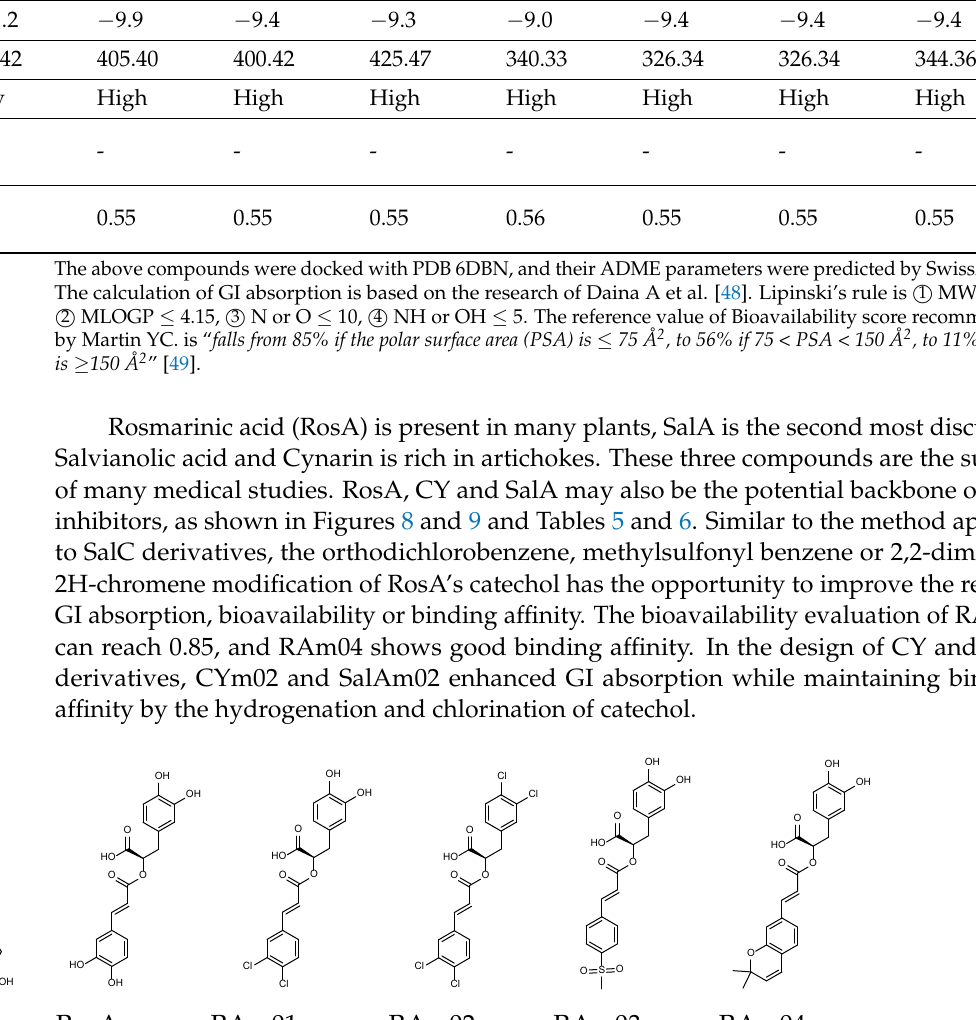
Figure 9. Chemical structures of Cynarin and SalA derivatives. Table 5. RosA Derivative with the prediction of ADMEADME parameters. Name